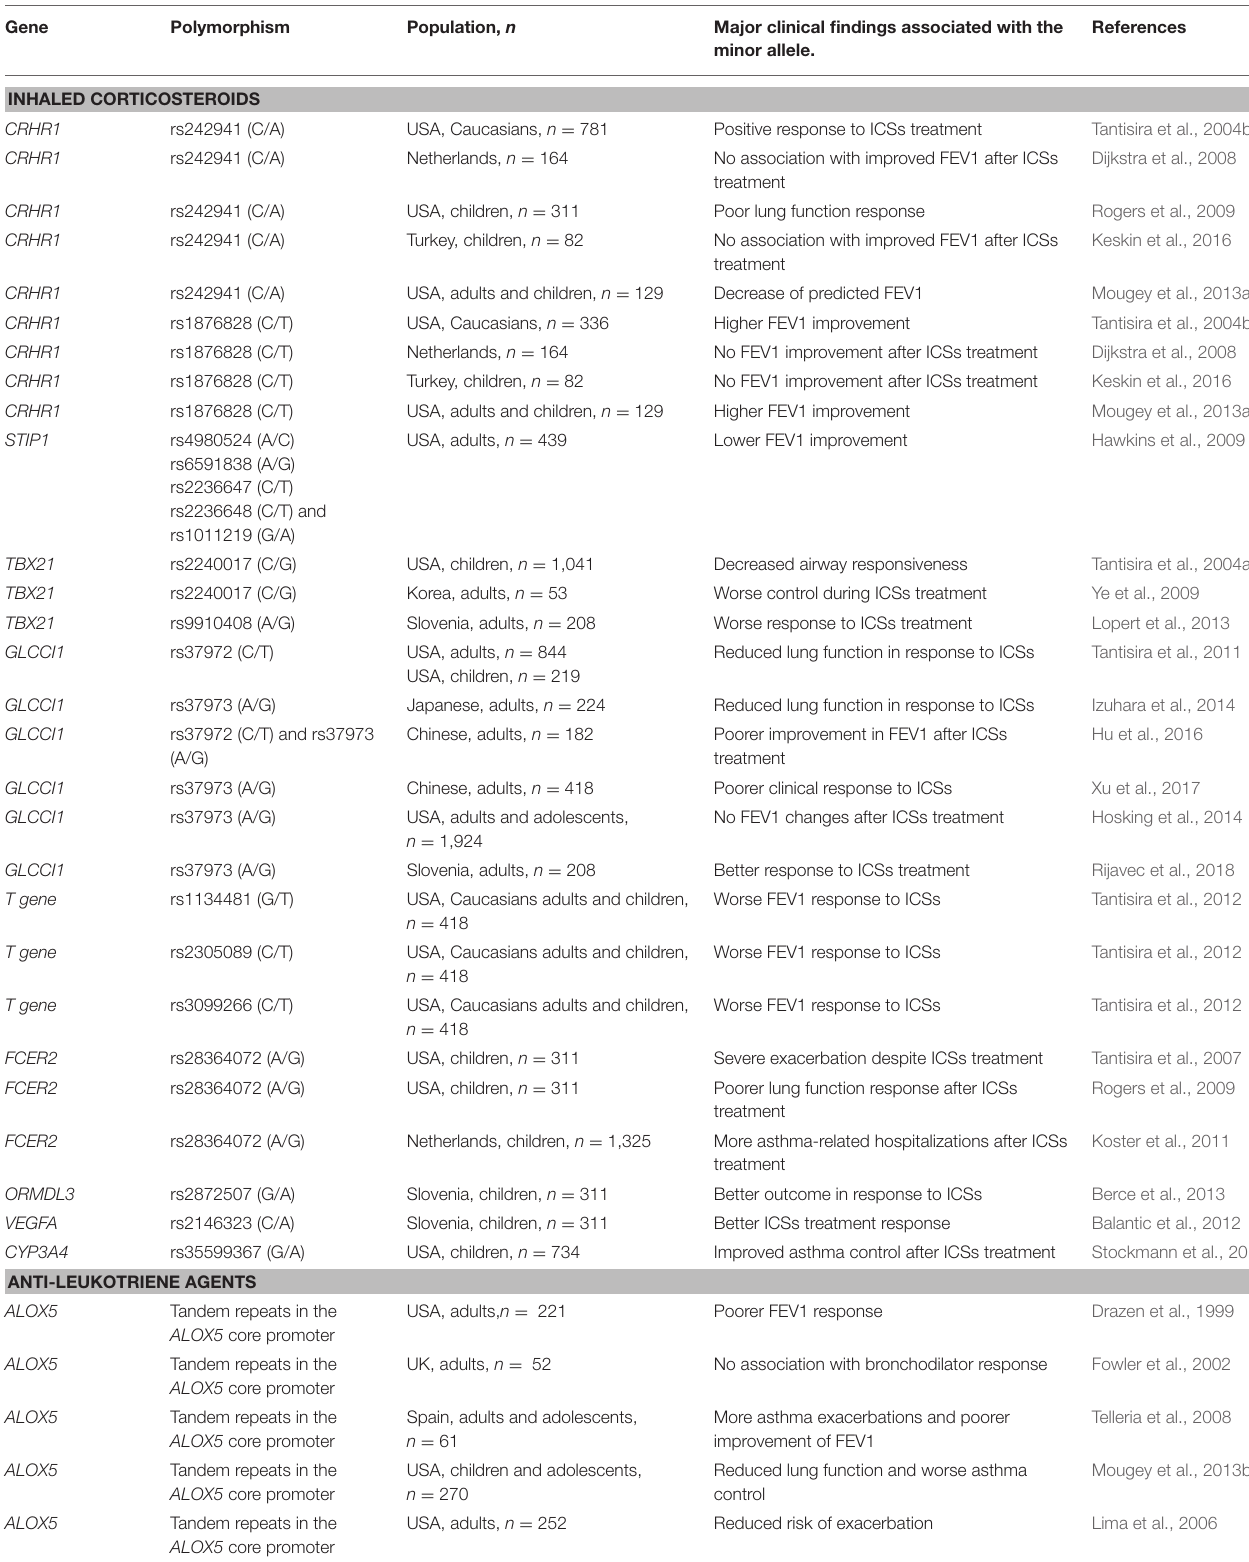
TABLE 1 | Summary of the major findings related to pharmacogenetics factors affecting asthma treatment